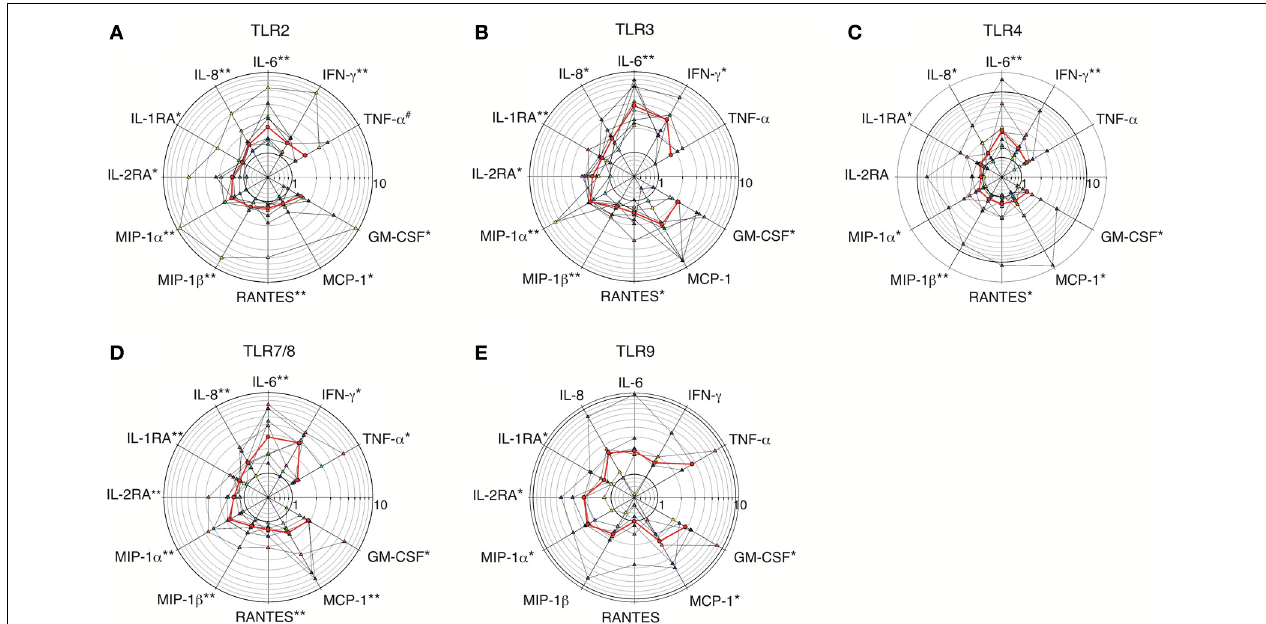
FIGURE 4 | Fold increases in cytokine secretion by dNK cells stimulated with TLR2, TLR3, TLR4, TLR7/8, and TLR9 agonists. Fold increases in cytokine levels in the supernatants of purified dNK cells incubated with TLR2 agonist (HKLM, n = 8) (A) ; TLR3 agonist (poly(I:C), n = 8) (B) ; TLR4 agonist (LPS, n = 8) (C) ; TLR7/8 agonist (R848, n = 8) (D) or TLR9 agonist